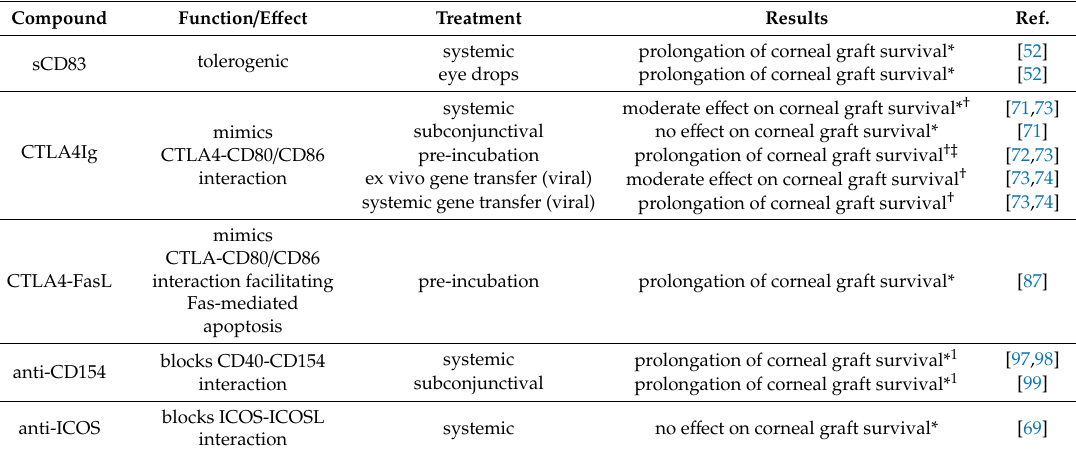
Figure 2. Overview of immune modulatory strategies to improve corneal graft survival targeting dendritic cells (DCs). Stimulatory effects of compounds are depicted in green, inhibitory effects of compounds are depicted in red. Ag – antigen; iDC – immature DC; mDC – mature DC; Teff – effector T cell; tolDC – tolerogenic DC; Treg – regulatory T cell; Trp – tryptophan. Table 1. Summary of immunomodulatory therapies to prevent corneal graft rejection targeting dendritic cells.